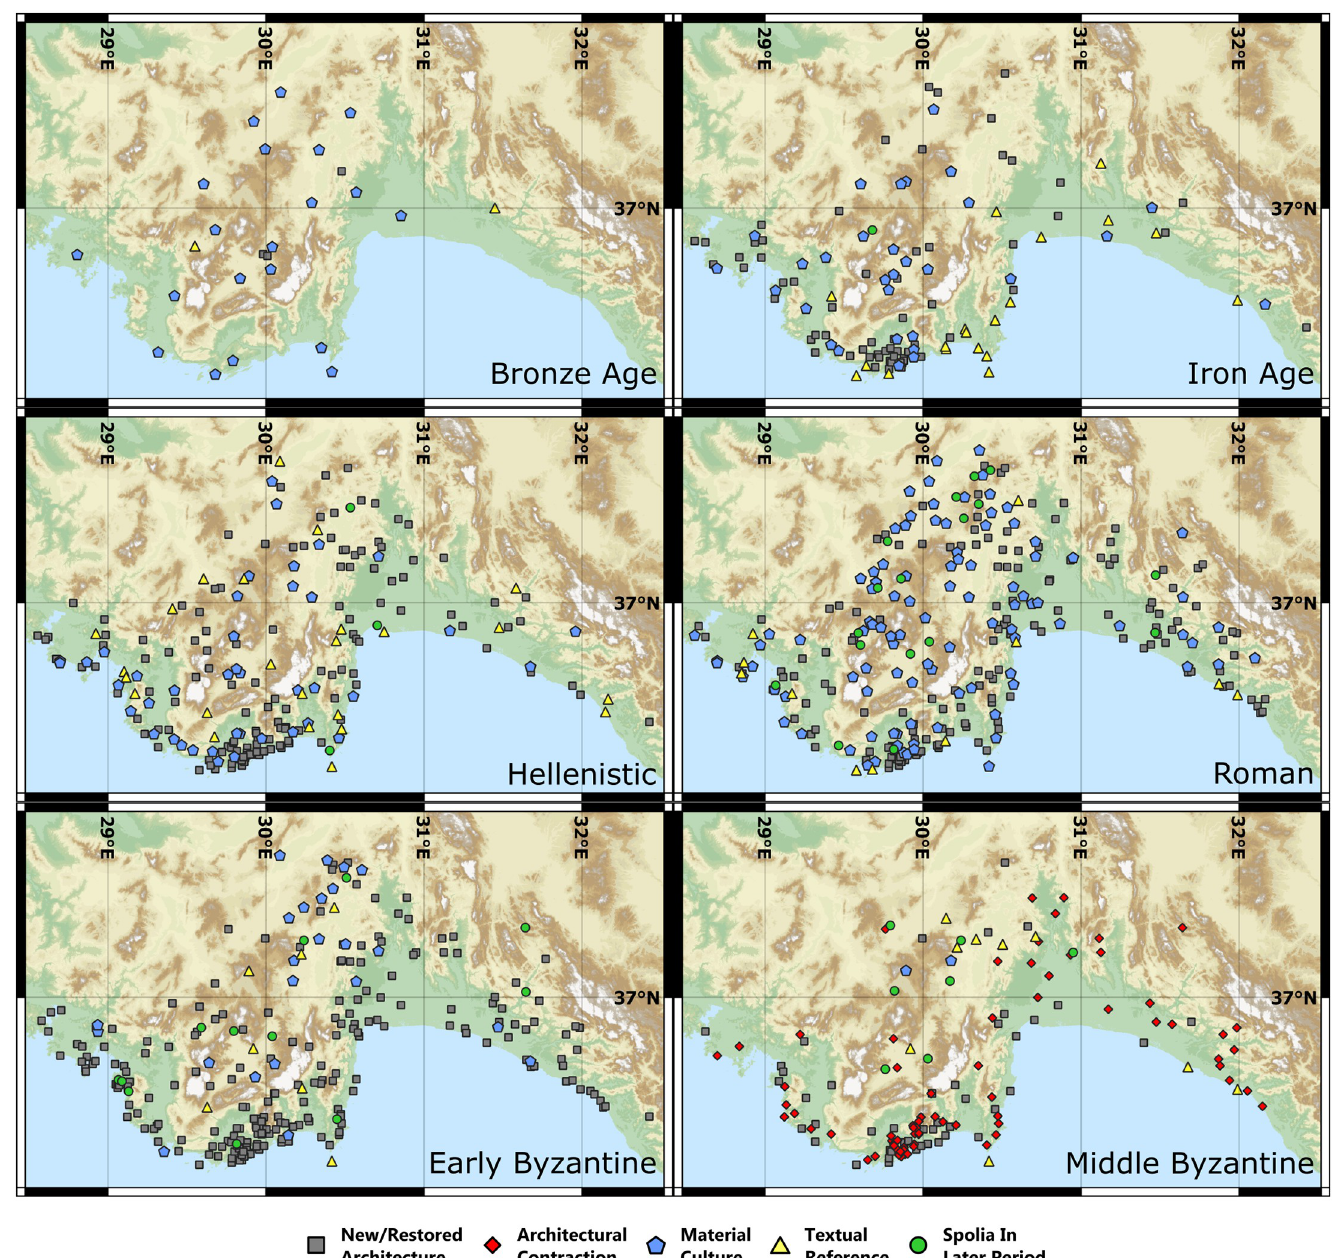
Fig 4. Maps showing settlement evidence by period. These were created in QGIS using the ASTER Global Digital Elevation Model v3 as a basemap [13].